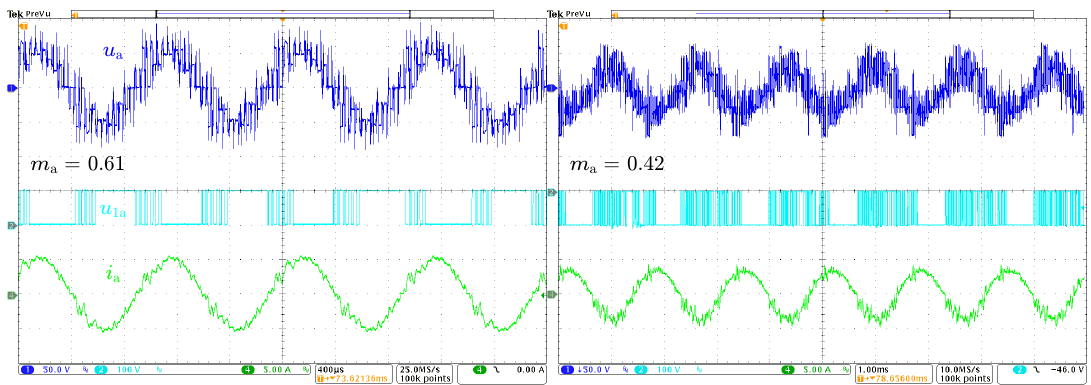
Figure 15. Example output voltages and currents for SVPWM control.